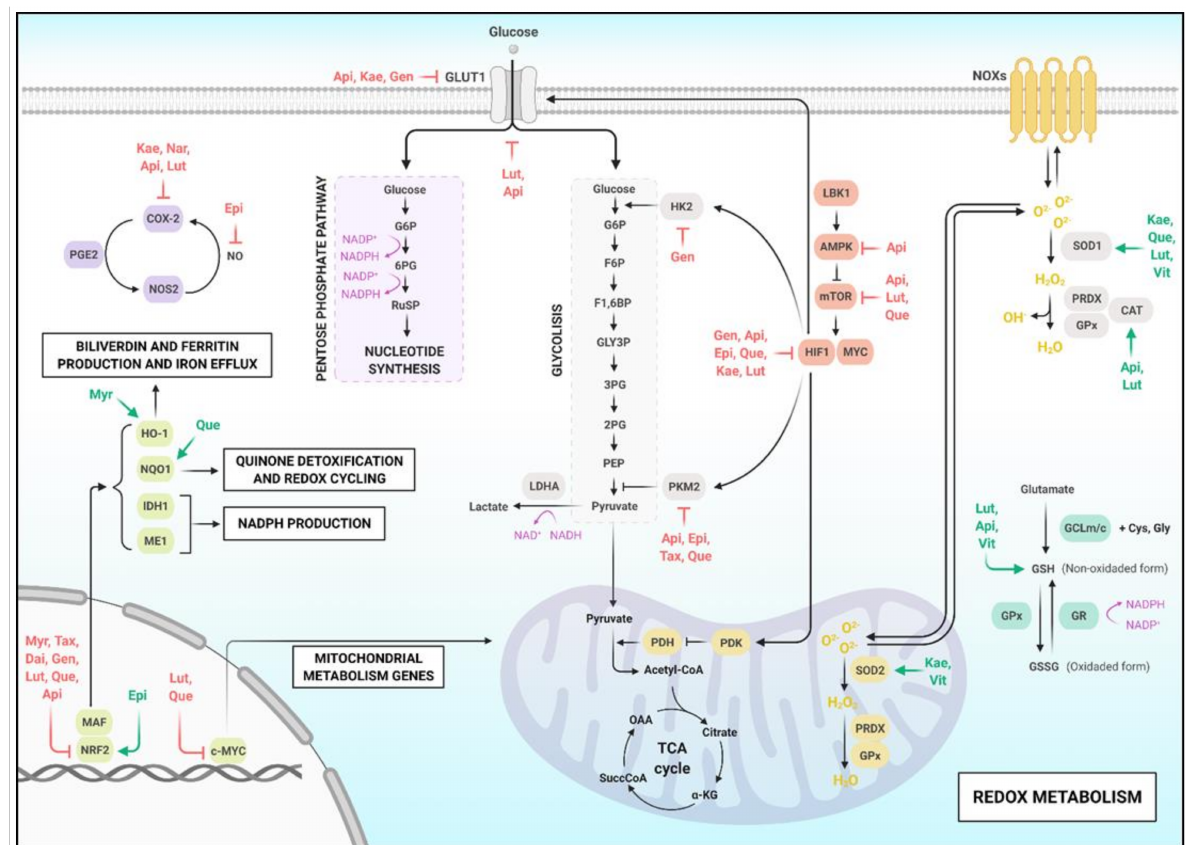
Figure 3. Flavonoids modulate redox metabolism pathways in cancer. Flavonoids, in addition to functioning as free radical scavengers, also act on antioxidant system enzymes such as Superoxide Dismutases (SODs), Catalase (CAT), Cyclooxygenase-2 (COX-2), Glutathione (GSH), and Glutathione Disulfide (GSSG) in cancer. Additionally, some flavonoids can interact with NRF2, activating many systems responsible for the redox balance and cell detoxification such as Heme Oxygenase-1 (HO-1), NAD(P)H Quinone Dehydrogenase 1 (NQO1), Isocitrate Dehydrogenase Dependent on NADP 1 (IDH1), and Malic Enzyme 1 (ME1). Hypoxia-Inducible Factor 1 (HIF1) has also been shown to be relocated, degraded, and inhibited by the action of flavonoids in cancer cells, thereby reducing receptors such as GLUT1 and glycolytic enzymes related to the Warburg effect such as PDK1, HK2, and PKM2, indirectly increasing the TCA cycle and not allowing the transformation of pyruvate into lactate. The inhibition of some cell growth proteins such as mTOR, AMPK, and AKT was also shown to be inhibited by flavonoids, affecting the c-Myc oncoprotein indirectly. Que: Quercetin; Epi: